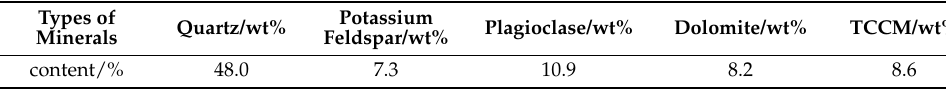
Table 2. Core XRD Mineral Composition.